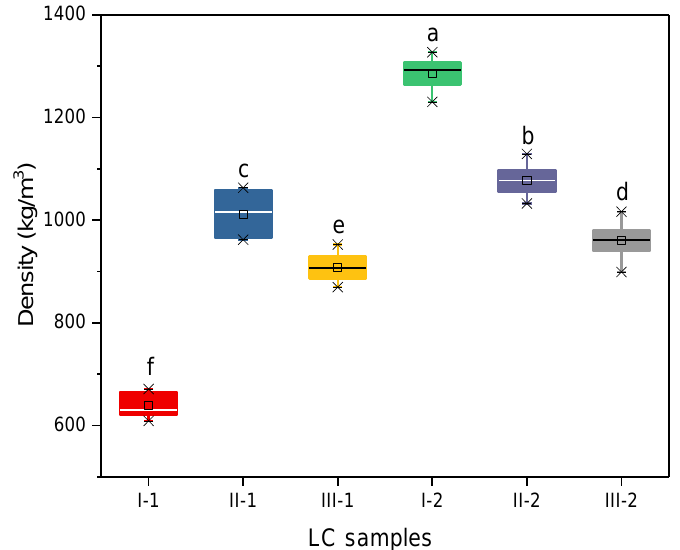
Figure 2. Densities of the LC samples. Different letters indicate significant difference at p < 0.05.